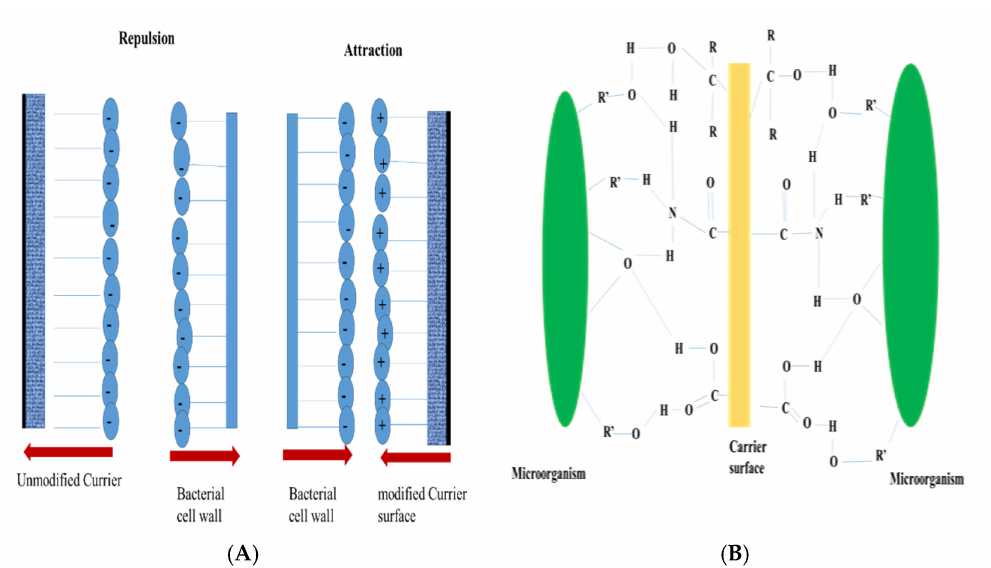
Figure 4. Interaction between the carrier surface and bacterial cell surface: ( A ) electrostatic interaction between the cell surface and the carrier surface; ( B ) hydrogen bond formation between the bacterial cell surface and carrier surface